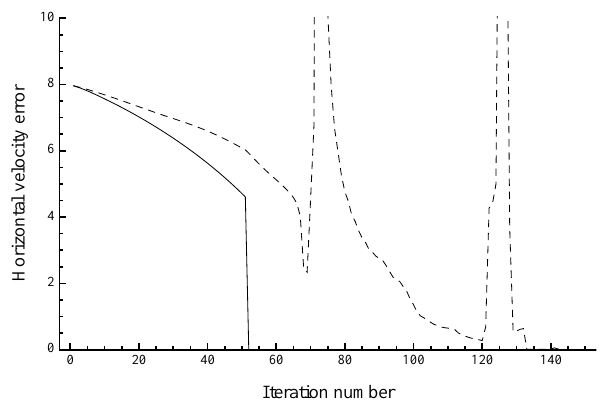
Fig. 6. Conjugate gradient convergence history for the reformulated Stokes system (solid line) and the standard Stokes system (dashed line) for a small problem ( N = 50, h = 0 .